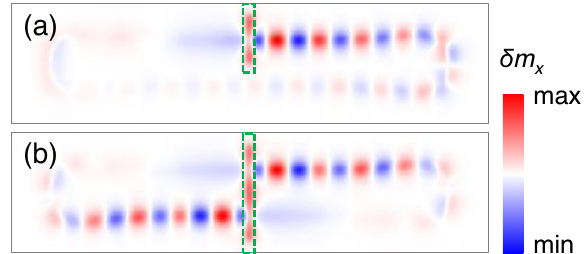
Fig. 6 Spin-wave propagation patterns along the rectangle-like domain wall of an elongated skyrmion. Spatial pro fi les of the fl uctuation in the x component of magnetization δ m x excited by a sinusoidal magnetic fi eld h = h 0 sin ð 2 π ft Þ ^ x , where h 0 and f are the amplitude and the frequency of this excitation fi eld, respectively. In our simulations, h 0 = 20 mT, f = 20 GHz, the spatial area of the excitation fi eld is a 4 × 50 nm 2 and b 4 × 100 nm 2 . The color bar denotes the value of the fl uctuation in the x component of magnetization δ m x .